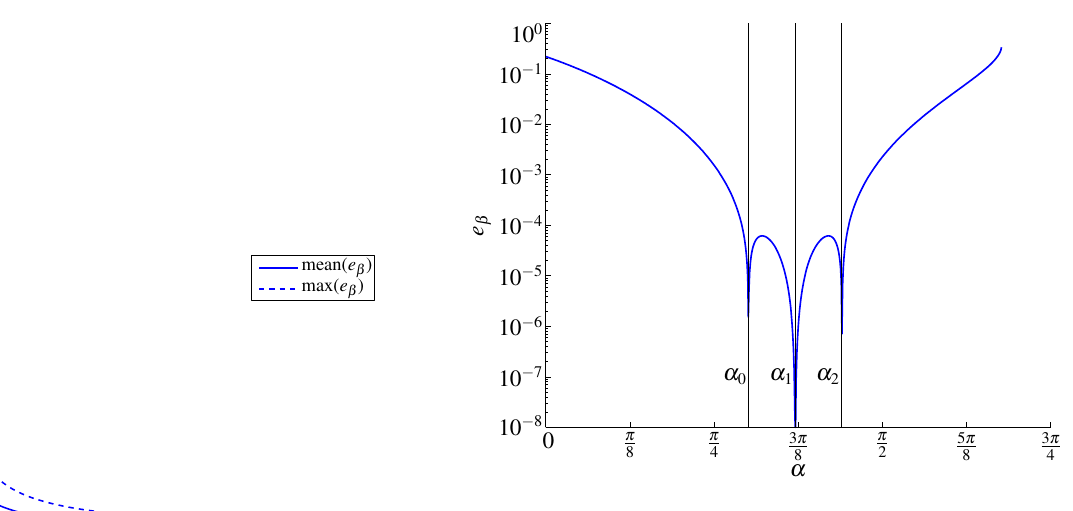
Figure 10. Error e β as a function of α with l 1 / r = 5.